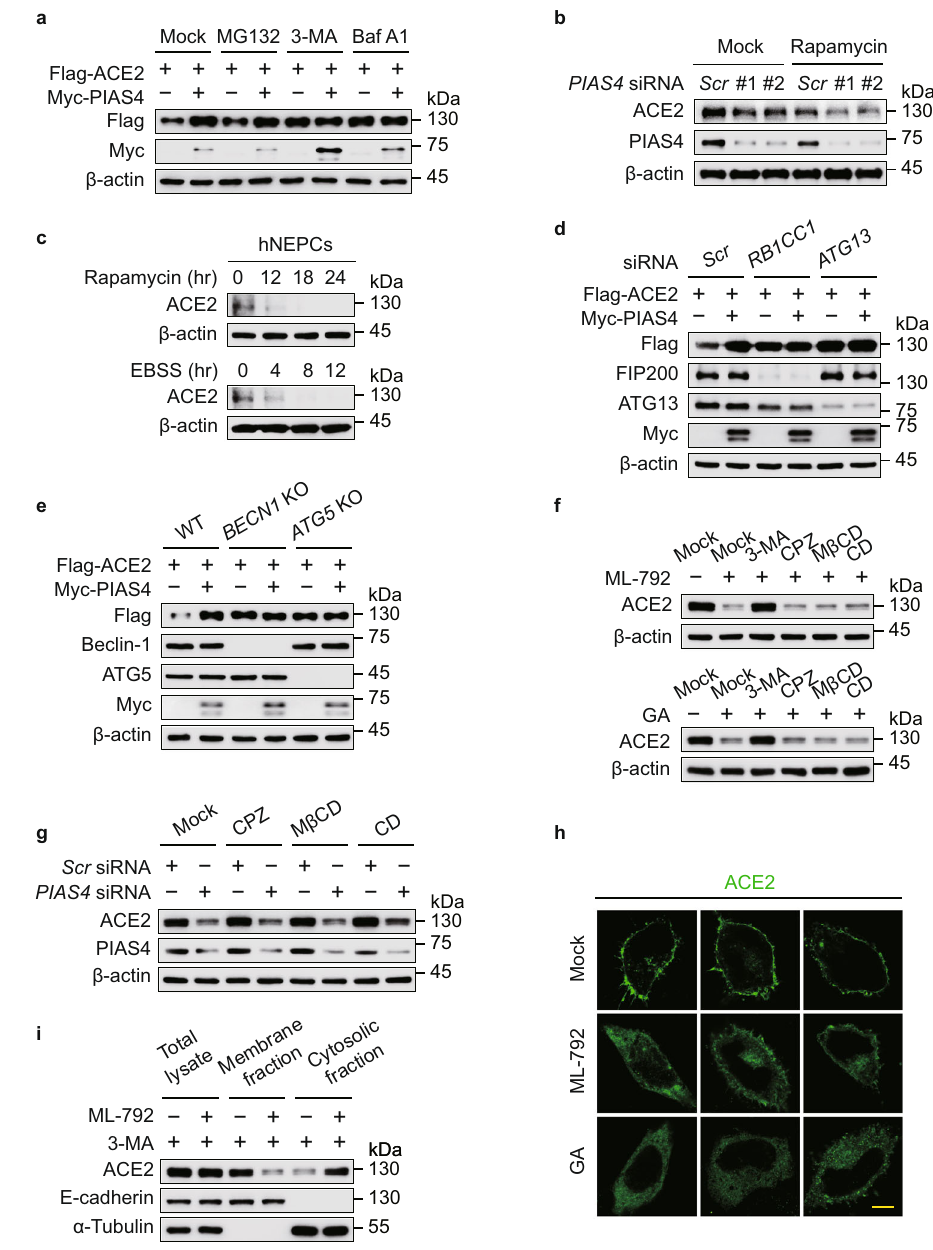
Fig. 4 | SUMO3 conjugation attenuates ACE2 degradation through autophagy. a 293T cells were transfected with plasmid encoding Flag-ACE2 together with Myc-PIAS4 vector treated with MG132 (10 μ M), 3-methyladenine (10mM), or ba fi lomycin A1 (0.2 μ M) for 6h. The cell extracts were analyzed by immuno- blotting. b Lysates of Calu-3 cells transfected with scramble or PIAS4 -speci fi c siRNA and treated with rapamycin (250nM) for 24h, were collected for immu- noblot analysis. c hNEPCs were treated with rapamycin (250nM) (up) or EBSS (down) with indicated time points, and the proteins were harvested for immu- noblot analysis. d 293T cells transfected with scramble siRNA along with RB1CC1 - or ATG13 -speci fi c siRNAs were transfected with plasmids encoding Flag-ACE2andMyc-PIAS4,thelysateswereanalyzedbyimmunoblotting. e Wild- type (WT), BECN1 - and ATG5 -knockout (KO) 293T cells were transfected with vectors of Flag-ACE2 and Myc-PIAS4, the lysates were subjected to immunoblot analysis. f Calu-3 cells were treated with ML-792 (10 μ M) (up) or ginkgolic